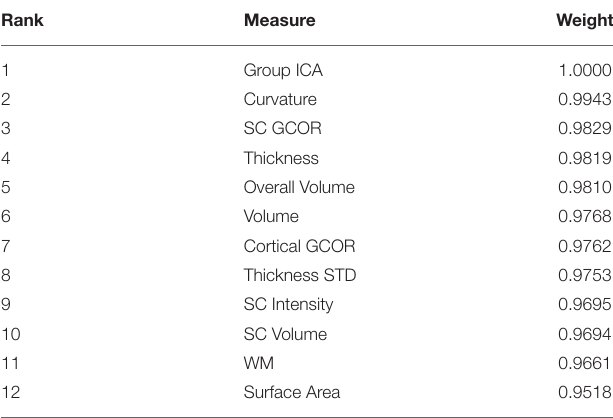
TABLE 3 | Weight and rank of each individual